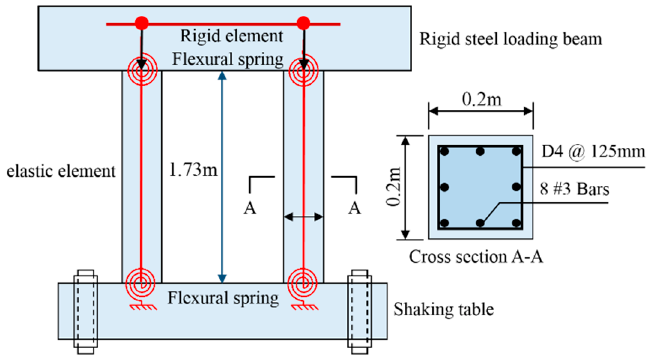
Figure 14. Prototype and model of the shaking table specimen. Table 6. ANN-based method for the LP model of RC column sample S2 [43].